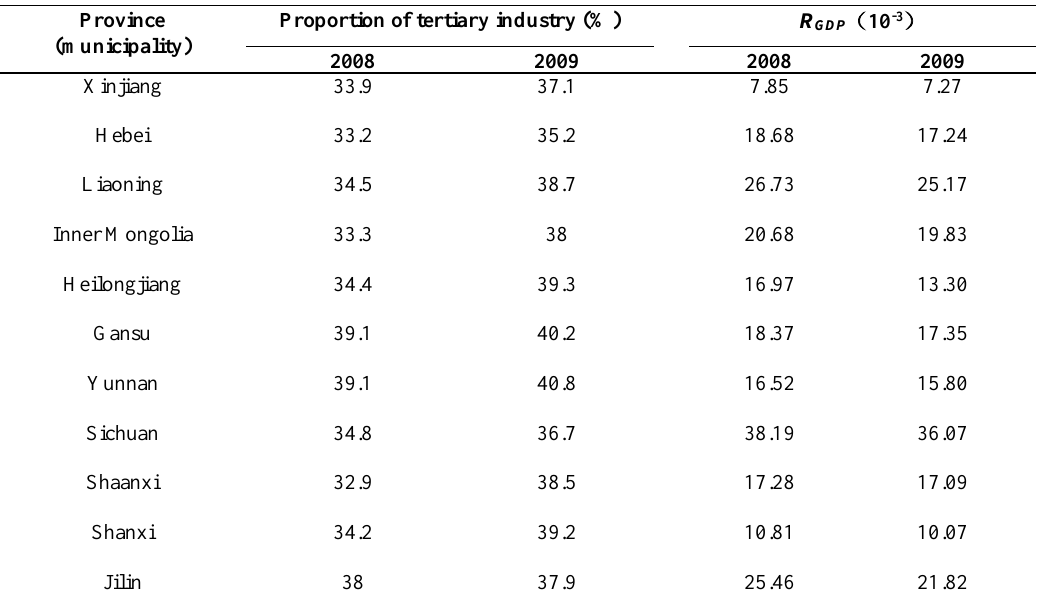
Table 3. The variation in proportion of tertiary industry and R GDP during